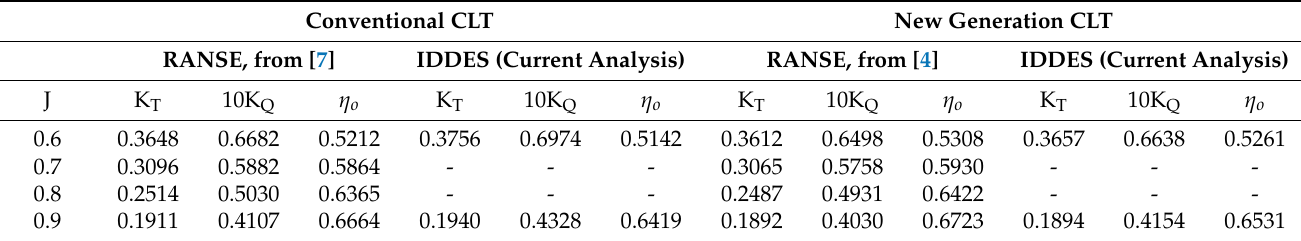
Table 4. Propellers performances. Comparison with the preliminary RANSE